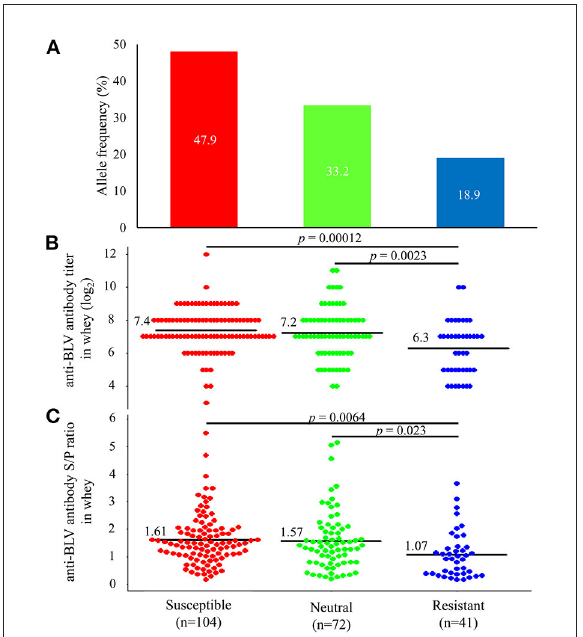
FIGURE5 Differences in the amount of anti-bovine leukemia virus (BLV) antibodies in whey from susceptible, resistant, and neutral dams. (A) Allele frequency of BoLA-DRB3 in 217 BLV-positive dams. BoLA-DRB3 allele were typed by the PCR-SBT method using DNA from blood from 217 BLV-positive dams. All dams were divided into susceptible, neutral, and resistant dam groups based on the BoLA-DRB3 allele status, as follows: susceptible dams carried at least one susceptible BoLA-DRB3 * 012:01 or * 015:01 allele (red) but did not carry resistant alleles; resistant dams carried at least one resistant BoLA-DRB3 * 002:01 , * 009:02 , or * 014:01:01 allele (blue); and neutral dams carried other alleles (green) in their genomes (B,C) Anti-BLV antibody titers (B) and S/P ratios at 32-fold dilution (C) in whey for each group. Anti-BLV antibody titers and S/P ratios at 32-fold dilution in whey were measured using an anti-BLV antibody ELISA. Mean anti-BLV antibody titers and S/P ratios among groups were compared using Tukey’s multiple comparison